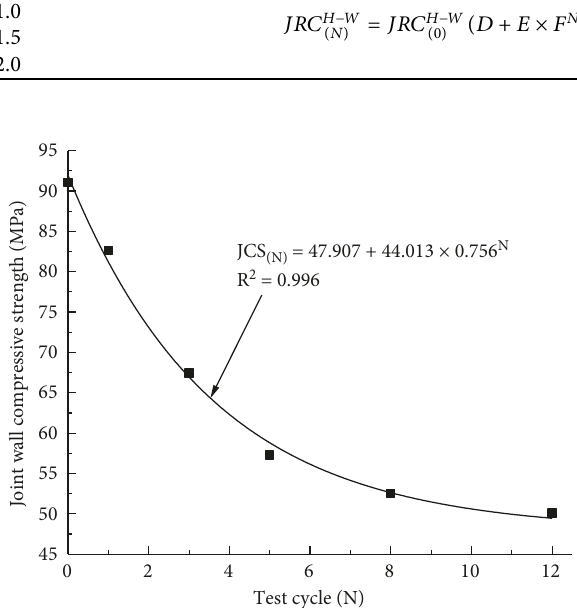
Figure 12: Strength deterioration curve of rock wall on joint surface under heat-wet cycles.